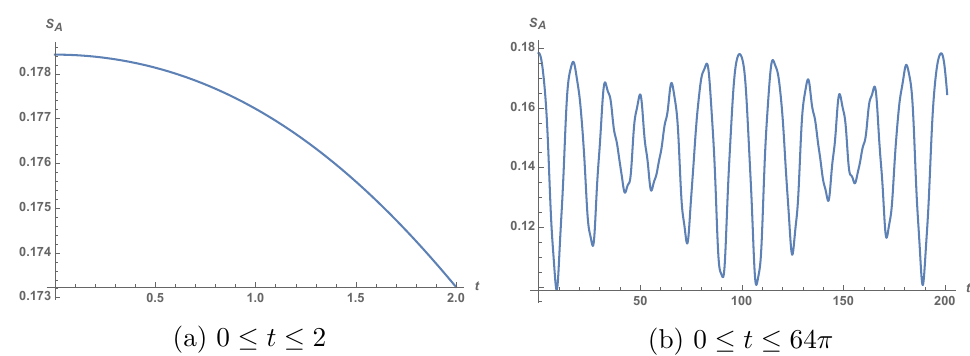
Figure 14 . Splitting local quench in spin-1/2 transverse Ising model: time evolution of EE S A for J = h = 1, L = 6, and j = 3, where the subsystem A is chosen to be A = f i j i = 4 ; 5 g . We can see oscillation in long time range, while the short-time behavior of S A is very similar to those in CFT